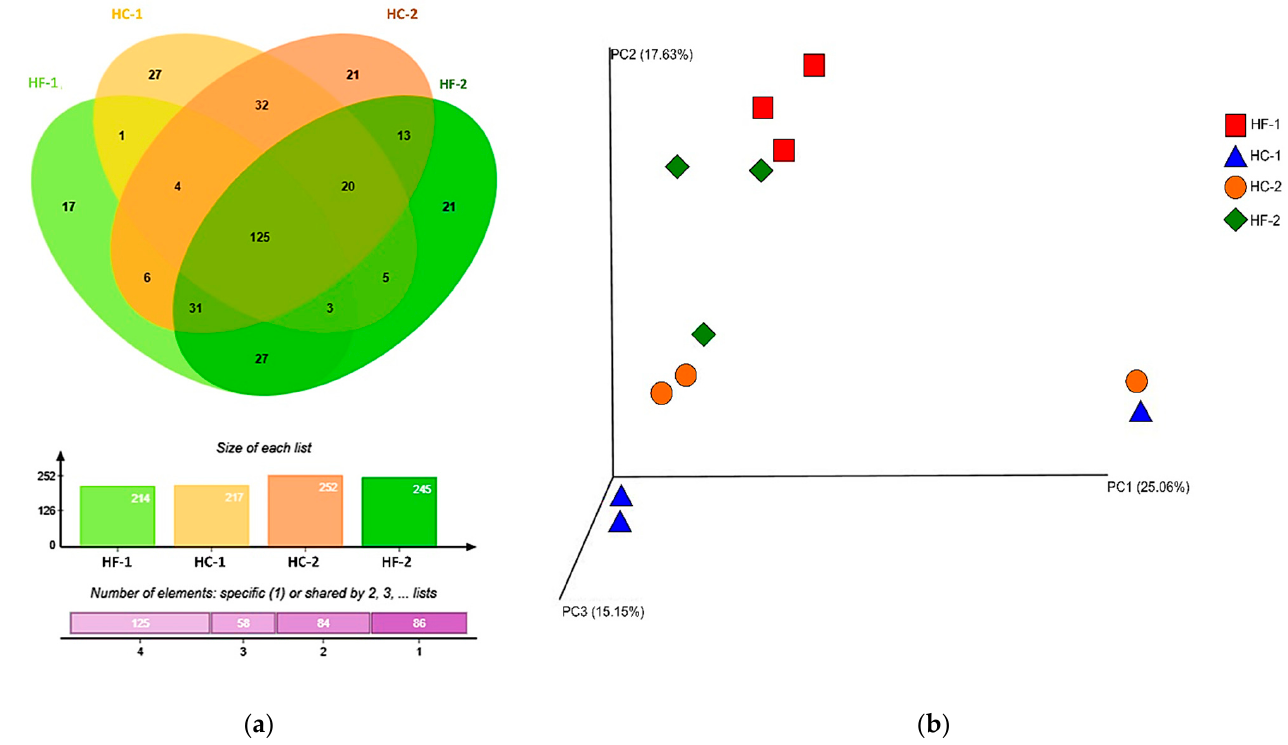
Figure 1. Venn diagram of rumen microbiome after transition of diet from high forage (HF-1) to high concentrate (HC-1 to HC-2), and back to high forage (HF-2), representing the unique, shared, and core microbiome. The bar graph below shows the size of representative species of observed operational taxonomic units (OTUs) per treatment. ( a ) Venn diagram was generated using jVenn [47]. ( b ) Principal coordinate analysis (PCoA) of all samples using Bray-Curtis distance derived from the subset of identified OTUs. EMPeror [48] was used to generate the PCoA plot. HF-1, high-forage diet; HC-1, high-concentrate diet; HC-2, high-concentrate diet; HF-2, high-forage diet.